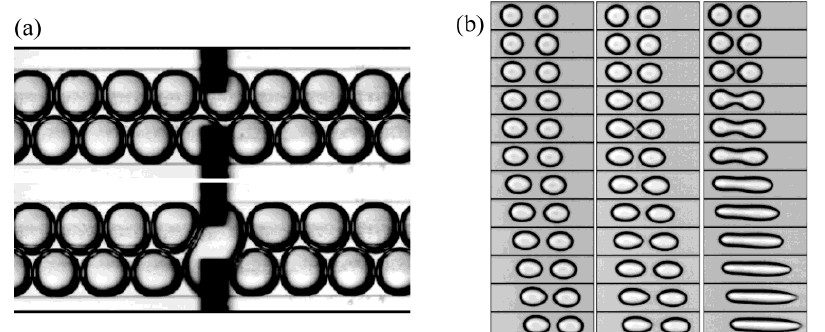
Figure 13. ( a ) Electrocoalescence of droplet pairs (electrodes are visible as shown black rectangles). Reprinted from [105] with permission from the American Institute of Physics (AIP); ( b ) EC as a function of interdroplet separation. Time sequences showing three different regimes: stable, partial merging and coalescence. Reprinted from [109] with permission from the American Physical Society